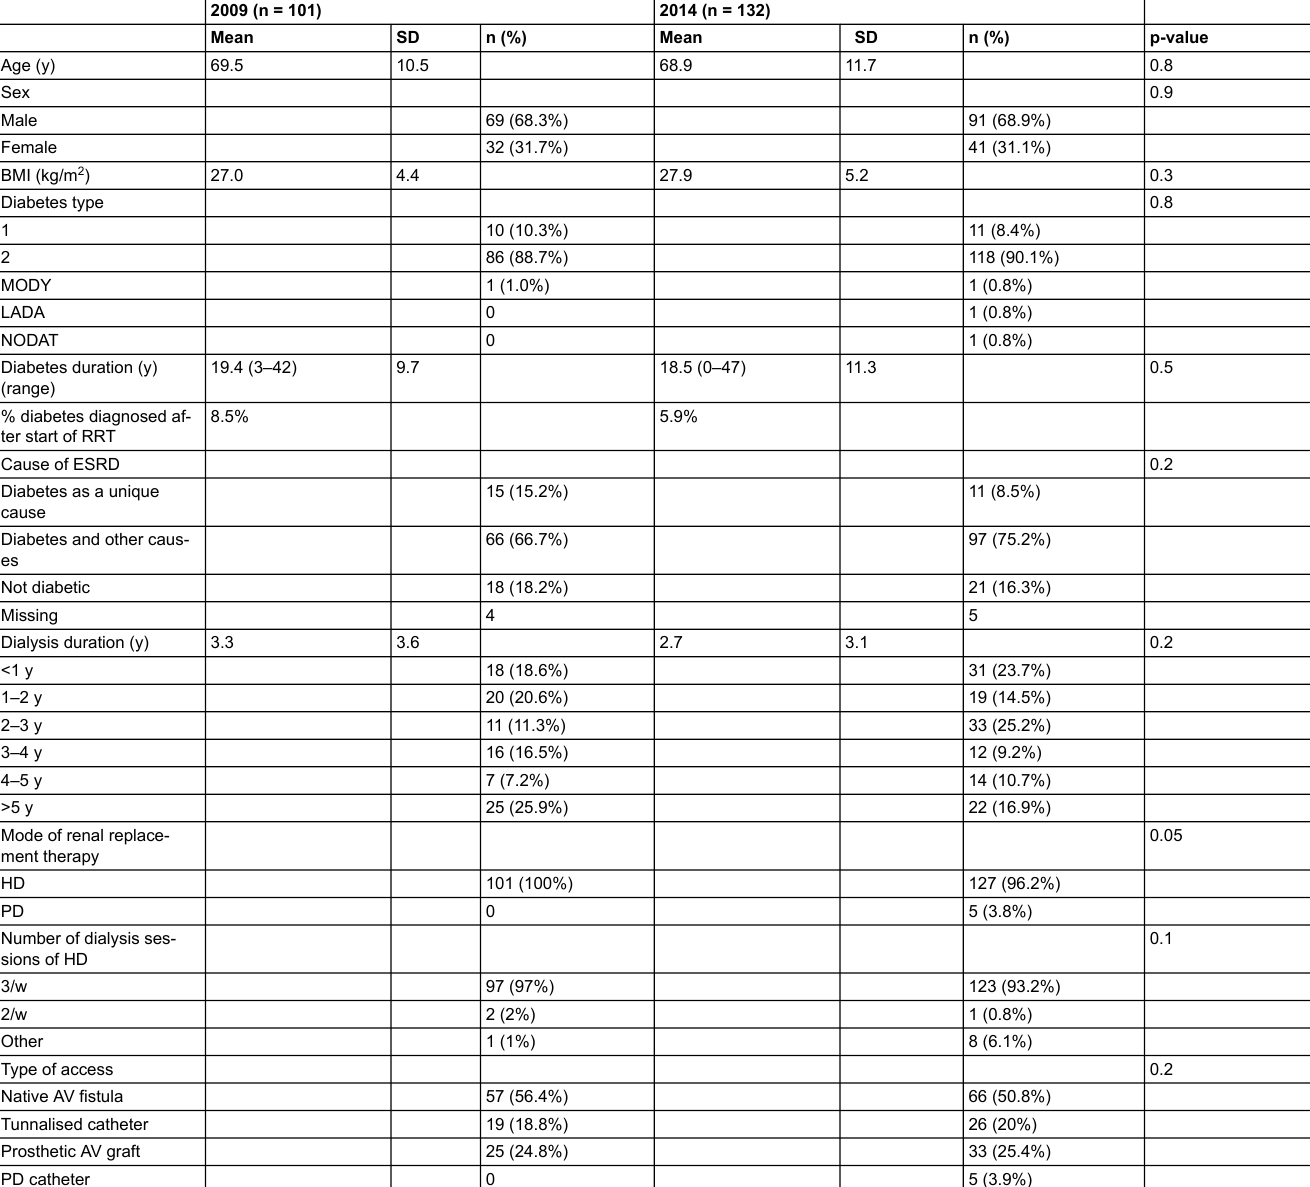
Table 1: Basic characteristics of end-stage renal disease patients with diabetes in 2009 and